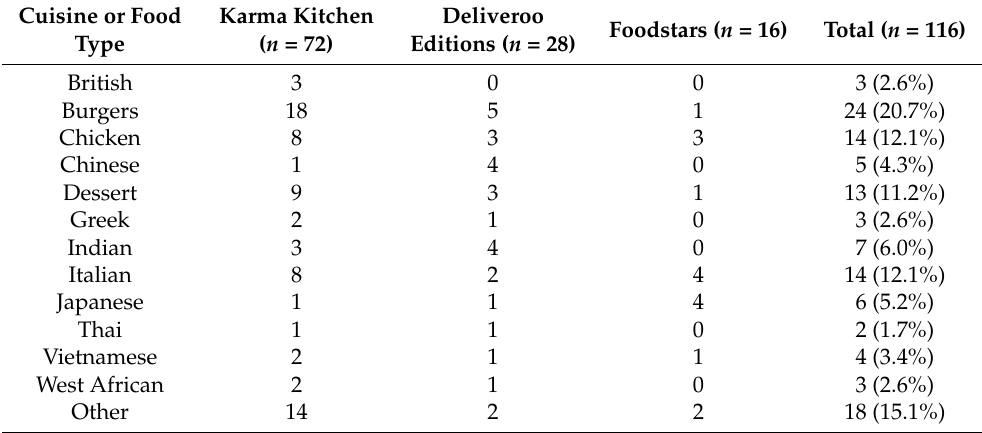
Table 3. Primary food type or cuisine offered by food outlets operating from dark kitchens in